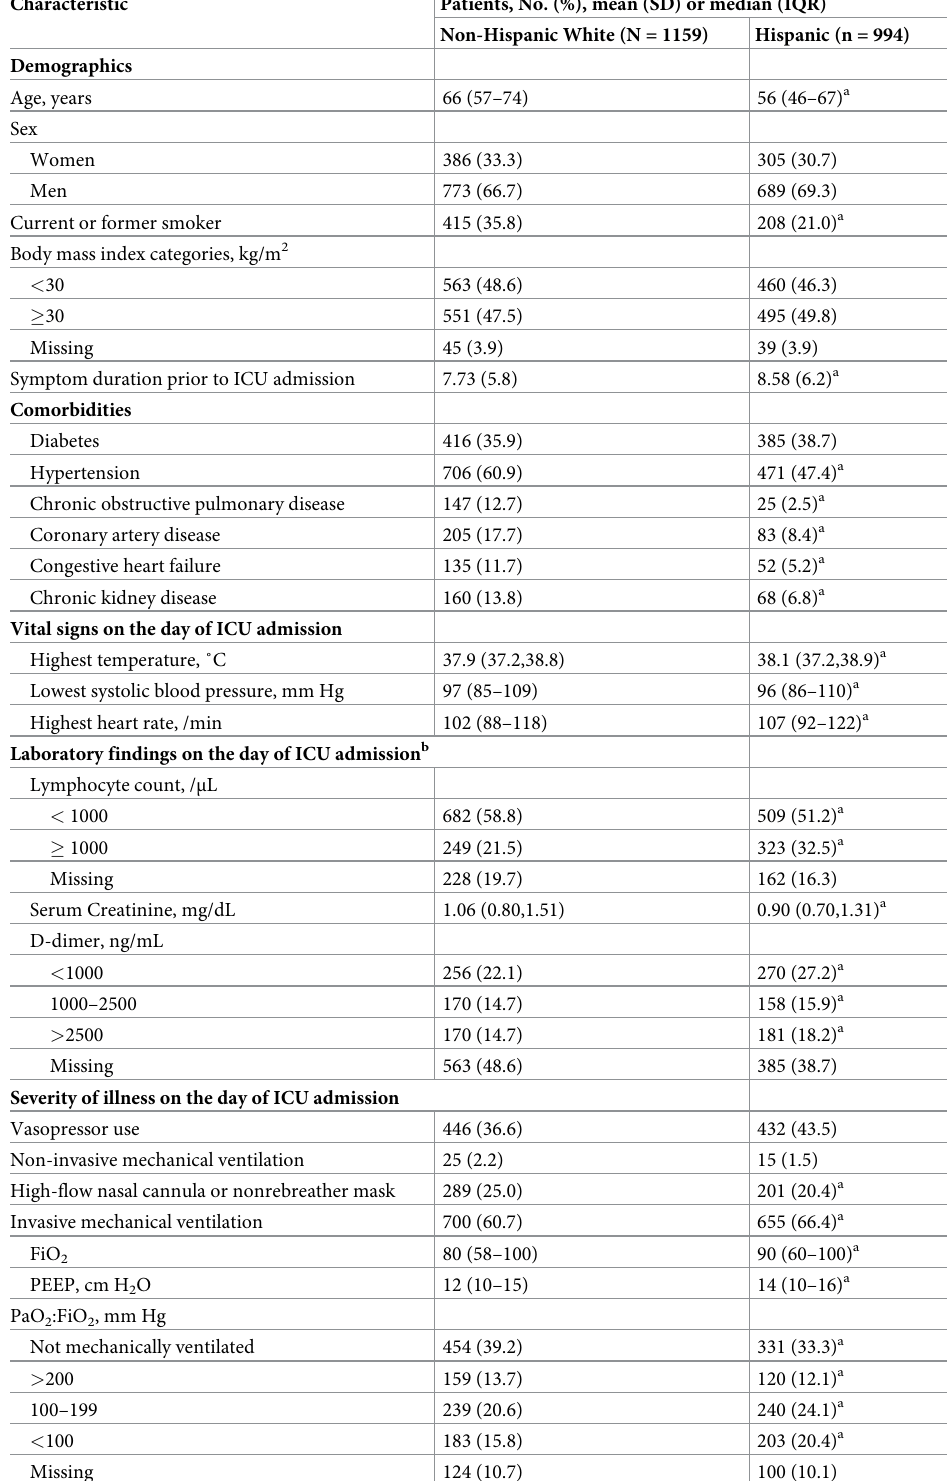
Table 1. Characteristics of adults with coronavirus disease 2019 admitted to the intensive care